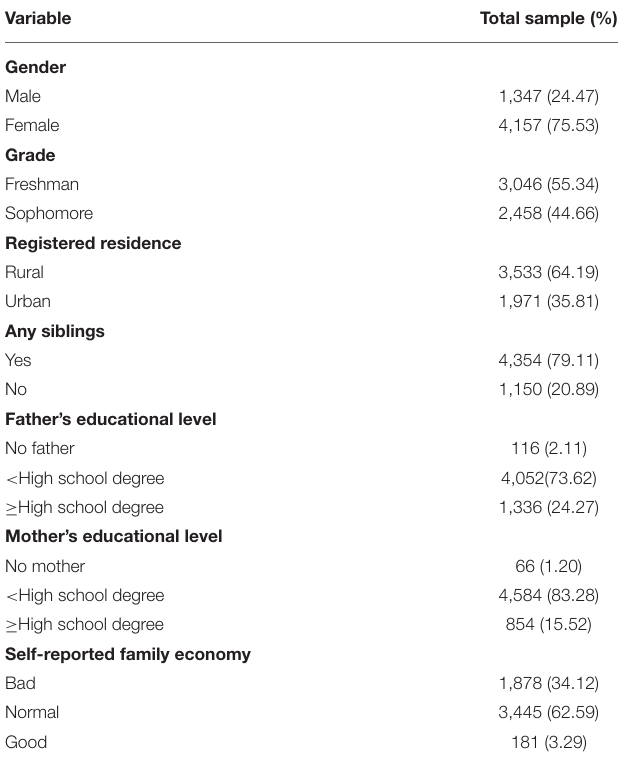
TABLE 1 | The demographic characteristic of